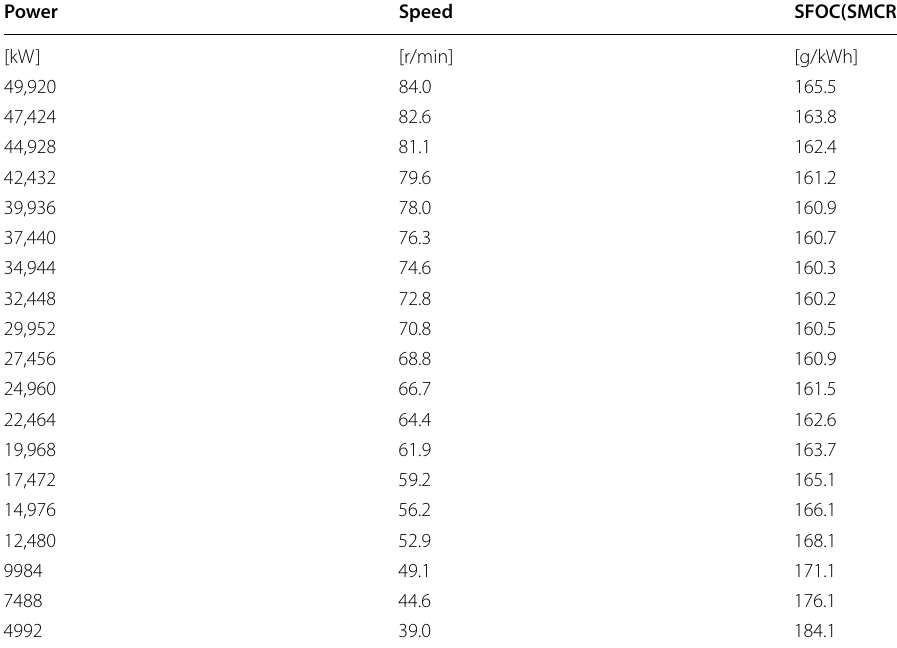
Table 12 Power-SFOC relation data table used in the present model for calculations of specific fuel oil consumption of diesel-like fuels and ammonia. Source MAN